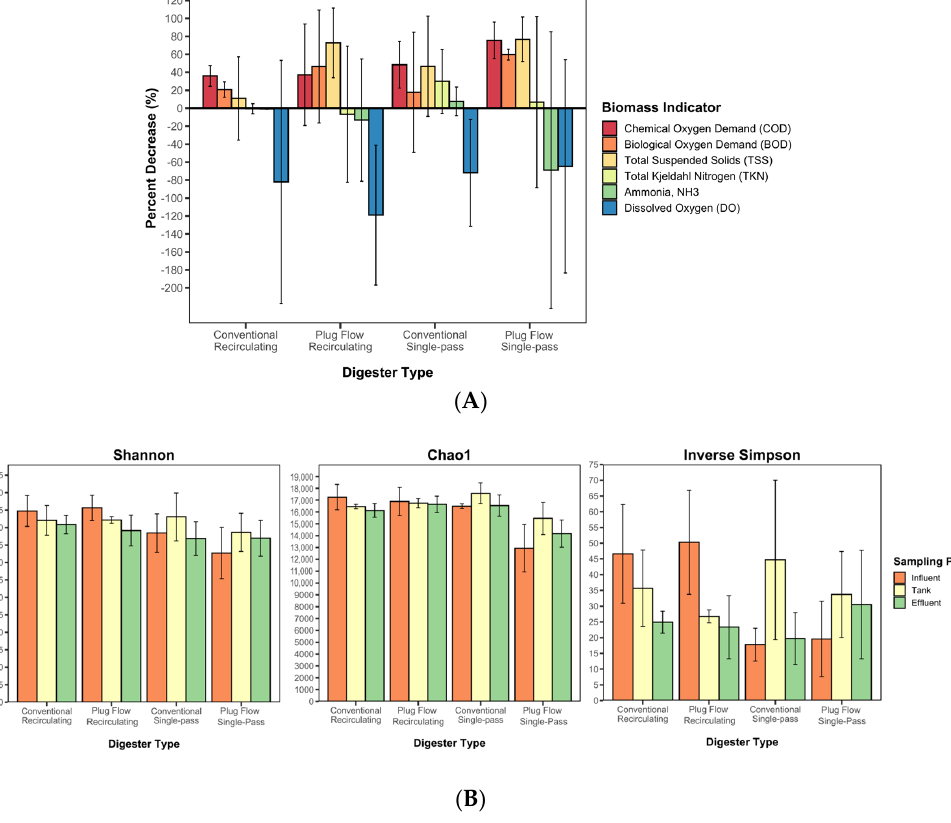
Figure 3. ( A ) Mean percent decrease in biomass chemical parameters across influent, tank, and ef- fluent sampling points. Error bars indicate standard deviation. ( B ) Mean Shannon diversity, Chao1 richness, and inverse Simpson evenness indices of the four digester types over influent, tank, and effluent sewage. Error bars indicate standard error ( n = 3).